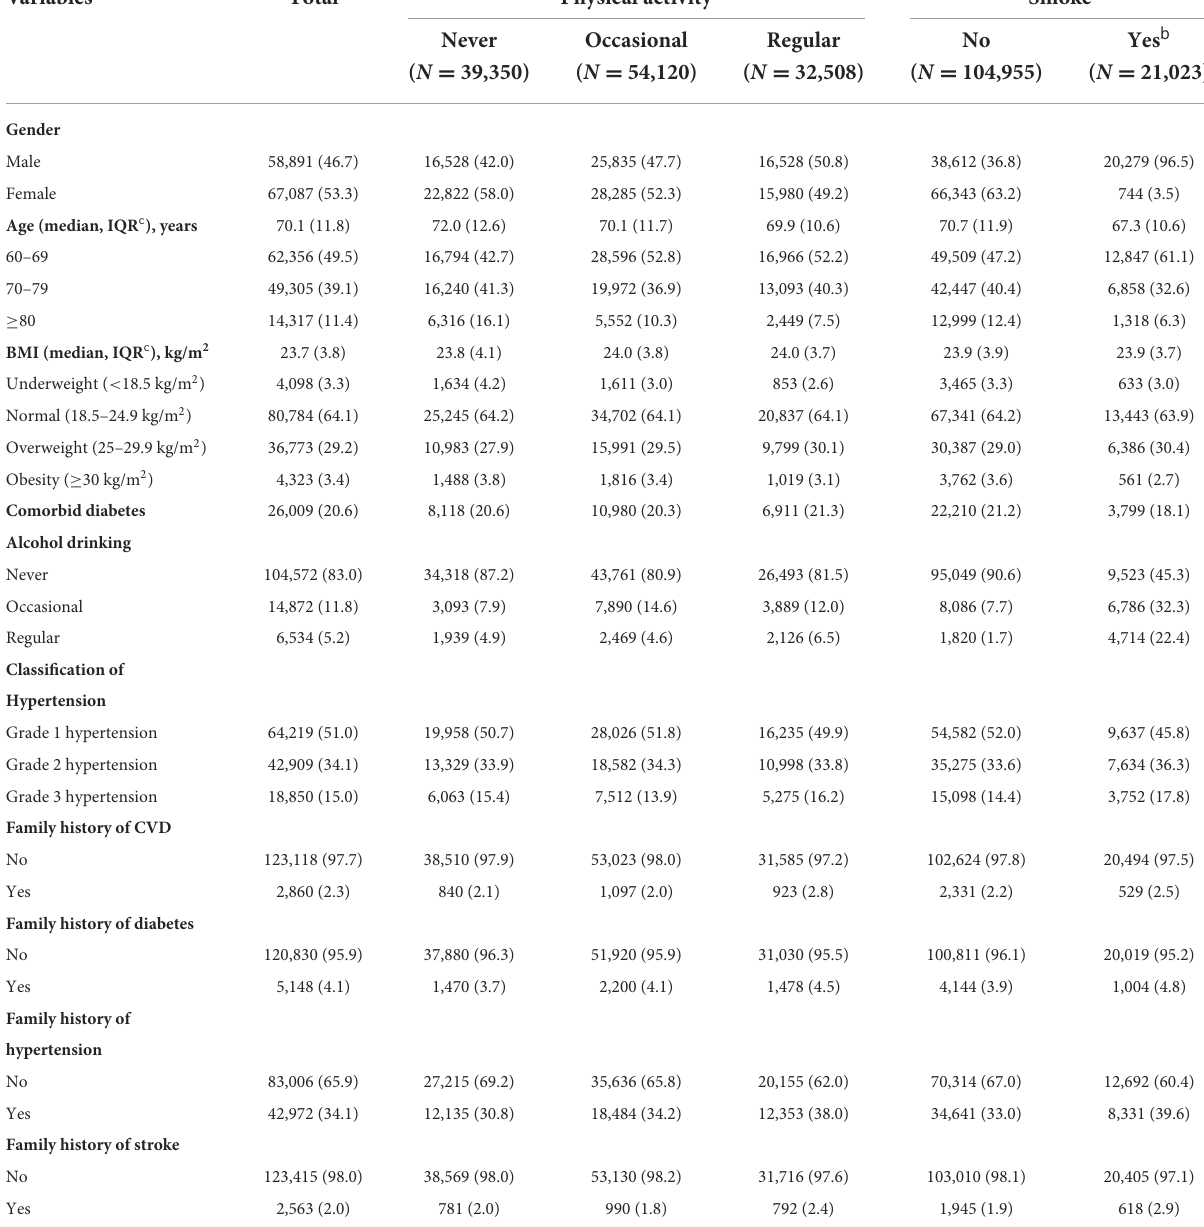
TABLE 1 Characteristics of participants according to physical activity and smoking ( n = 125,978) a